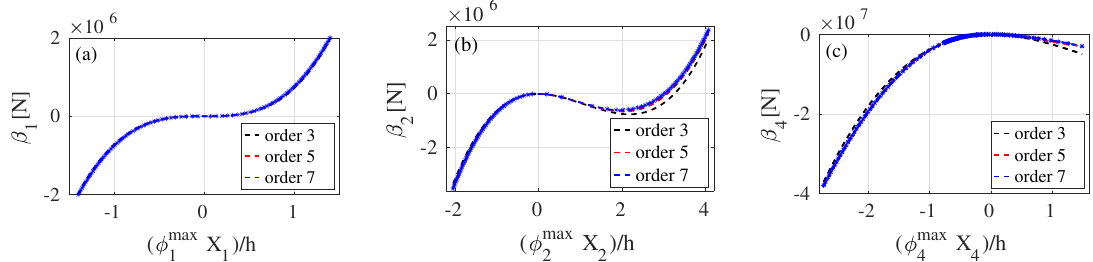
Figure 4. Illustration of the fitting procedure for the ICE method: Blue stars ∗ represent the outputs obtained from the static applied force on the finite element (FE) model, and the dashed curve is the fitted polynomial; black: order 3, red: order 5, blue: order 7. ( a ) Straight beam, ( b ) shallow arch for which the first bending mode appears as the second mode, and ( c ) non-shallow arch (first bending mode in fourth